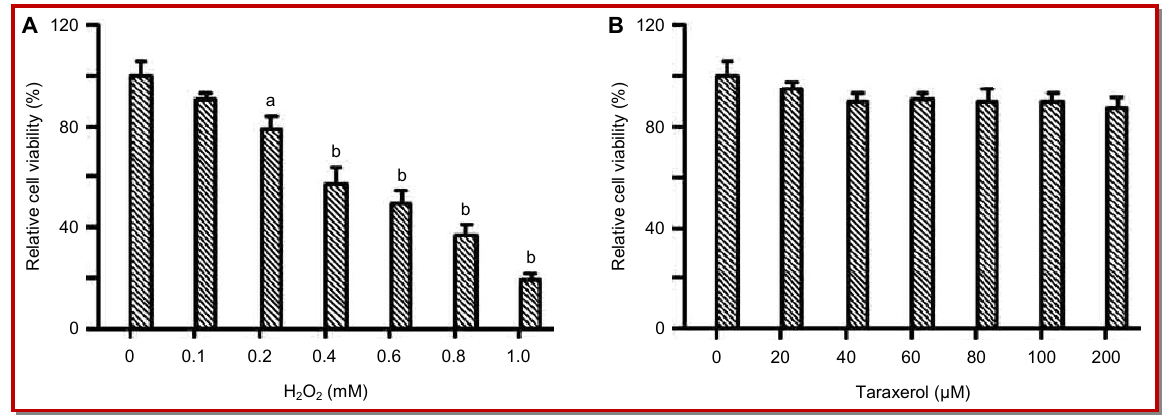
Figure 1: Effects of H 2 O 2 and taraxerol on the cell viability of L02 cells. L02 cells were treated with various concentrations of H 2 O 2 or taraxerol for 12 hours, then measured by MTT analysis. A) Effect of H 2 O 2 on the cell viability of L02 cells. B) Effect of taraxerol on the cell viability of L02 cells. Data are expressed as mean ± SD (n = 6). a p<0.05, b p<0.01 compared with